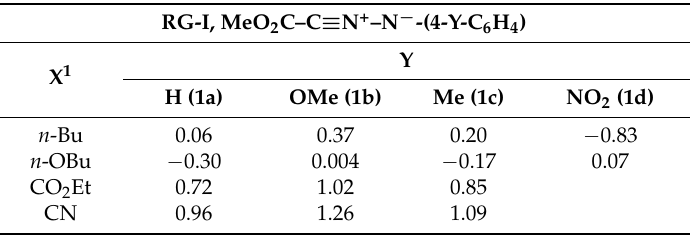
Table 7. Electron chemical potential difference µ (nitrilimine 1 )– µ (ethene) in eV for the RG-I. Positive values indicate that the nitrilimine transfers electrons to the